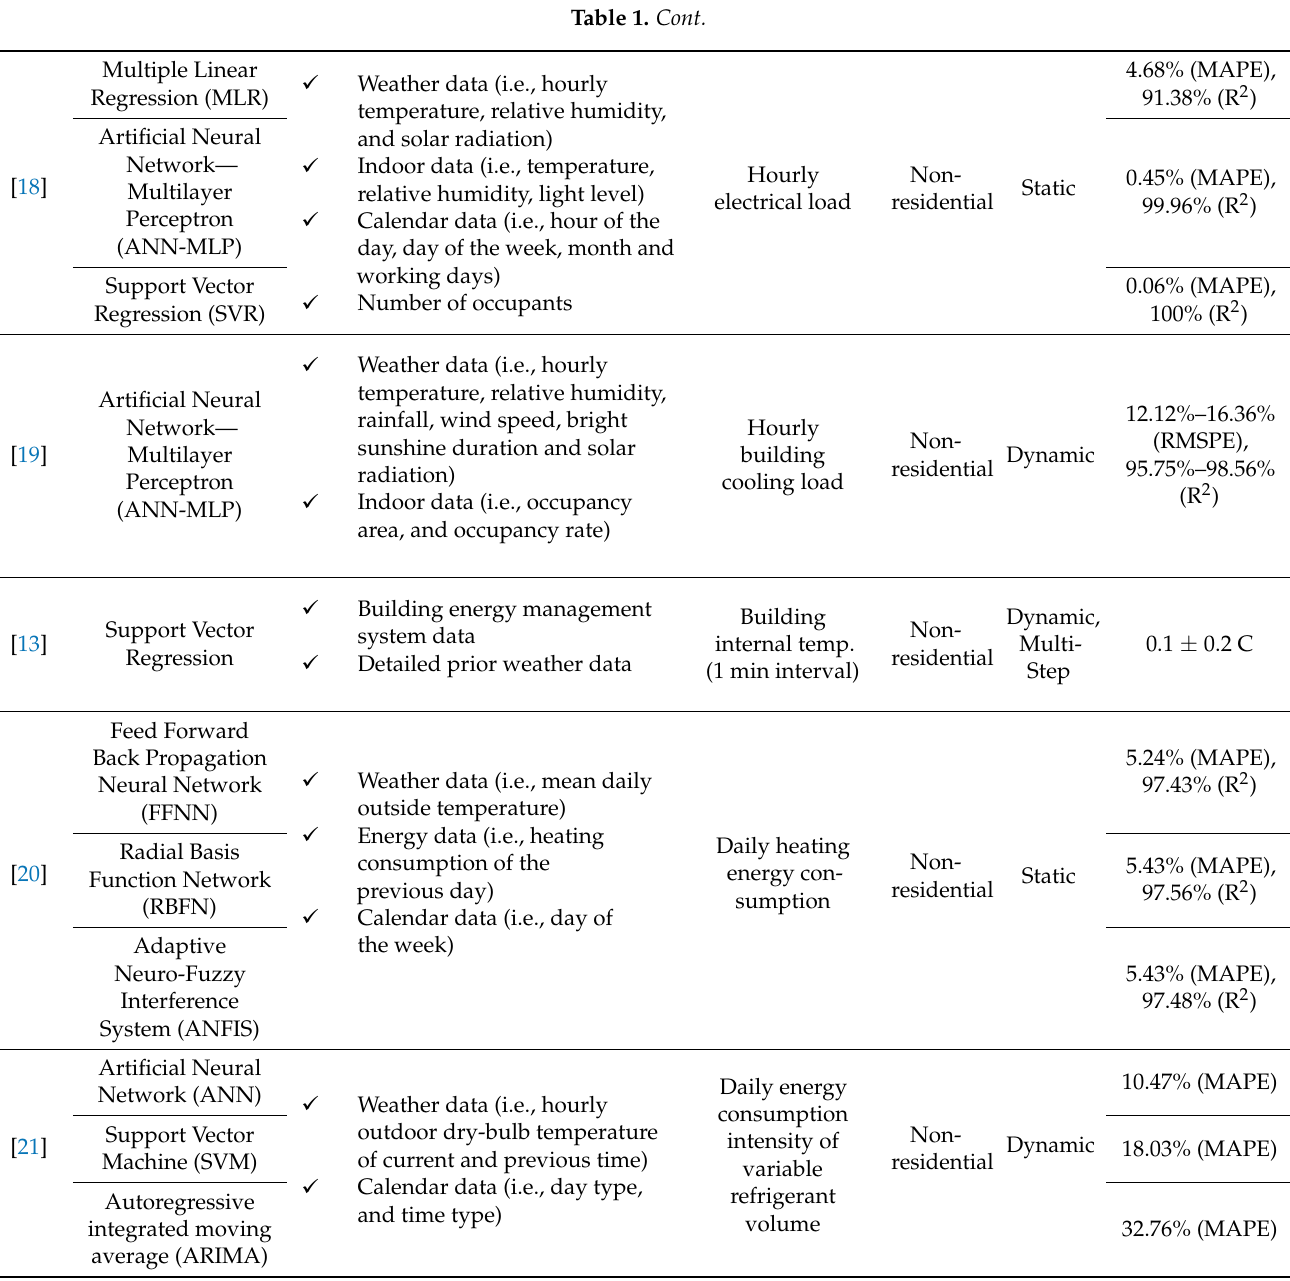
Table 1. Summary of prior research in predicting energy consumption in residential buildings.